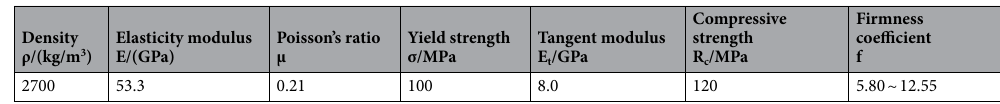
Table 2. Rock material mechanical parameters.